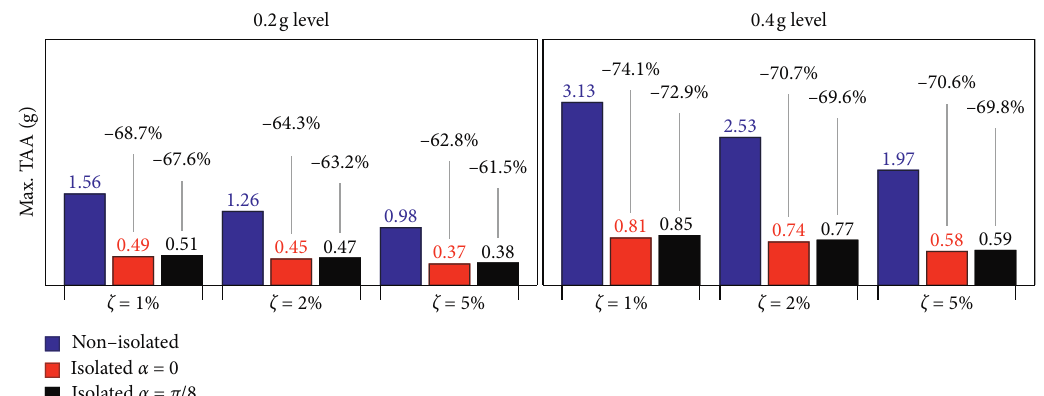
Figure 18: Maximum top absolute acceleration (TAA) of the nonisolated and isolated system and their change under different parameters of ζ and α at two seismic qualification levels.